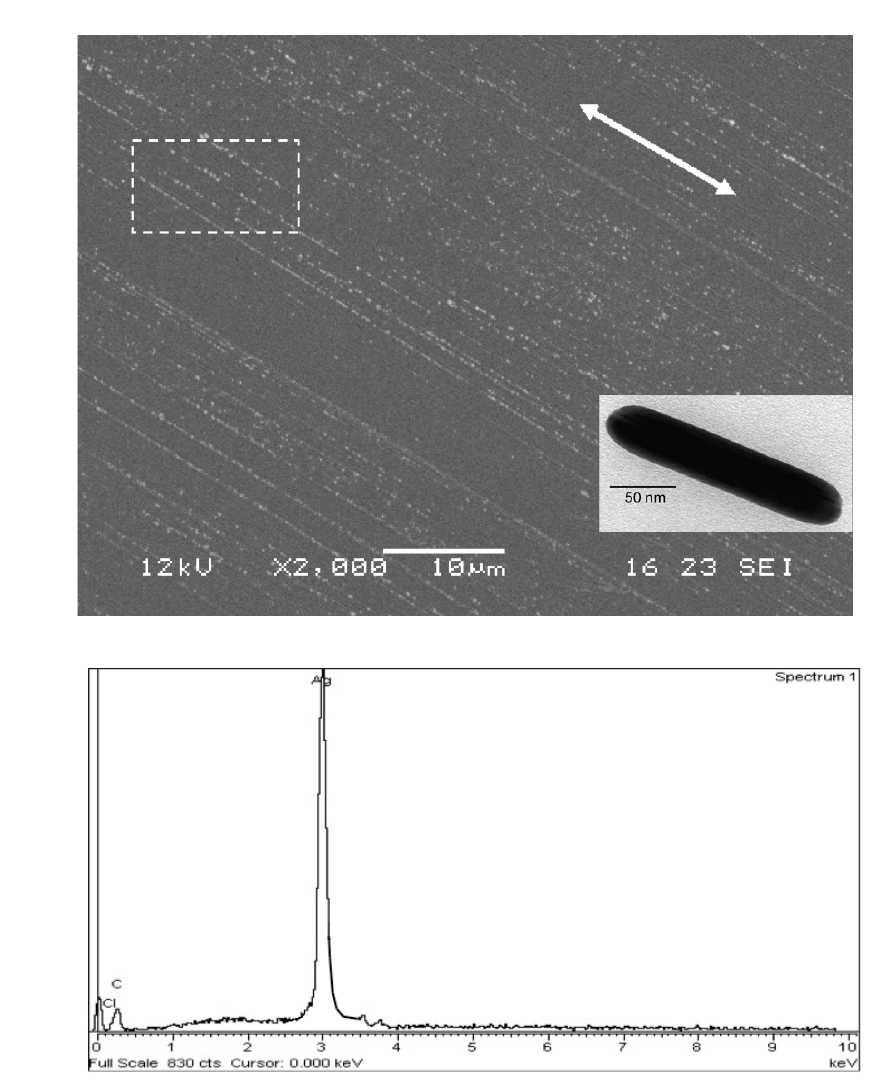
Figure 4. (a) SEM micrograph of a PVA@AgNR oriented film (Dr = 5) The white arrow denotes the stretching direction. In the inset: TEM image of an AgNR embedded in the polymer matrix. (b) Energy dispersive (EDS) spectrum of the film polymer surface. The white rectangle in (a) highlights the area where the EDS analysis was performed.